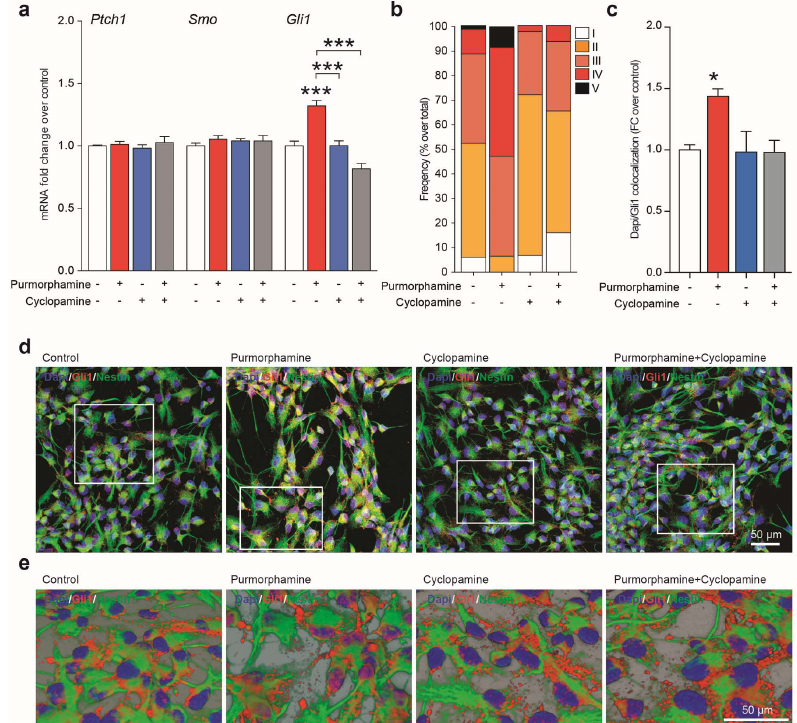
Figure 4. Purmorphamine induces Gli1 activation within NSCs. ( a ) mRNA levels of patched (Ptch1), smoothened (Smo) and Gli1 in control NSCs and NSCs exposed to 1 µ M of purmorphamine, cyclopamine or purmorphamine plus cyclopamine. Data are mean fold change over control ( ± SEM) of n = 3 independent replicates. ( b ) Quantification of the intensity range (I and II = low; III = medium; IV and V = high) frequency of Dapi / Gli1 colocalization in control NSCs and NSCs exposed to 1 µ M of purmorphamine, cyclopamine or purmorphamine plus cyclopamine. ( c – d ) Dapi / Gli1 colocalization ( c ) and representative confocal pictures ( d ) in control NSCs and NSCs exposed to 1 µ M of purmorphamine, cyclopamine or purmorphamine plus cyclopamine. ( e ) 3D deconvolutions of Gli1 and Nestin of the confocal images in ( c ) highlighting the Dapi-Gli1 juxtaposition. * p -value < 0.05; *** p -value <